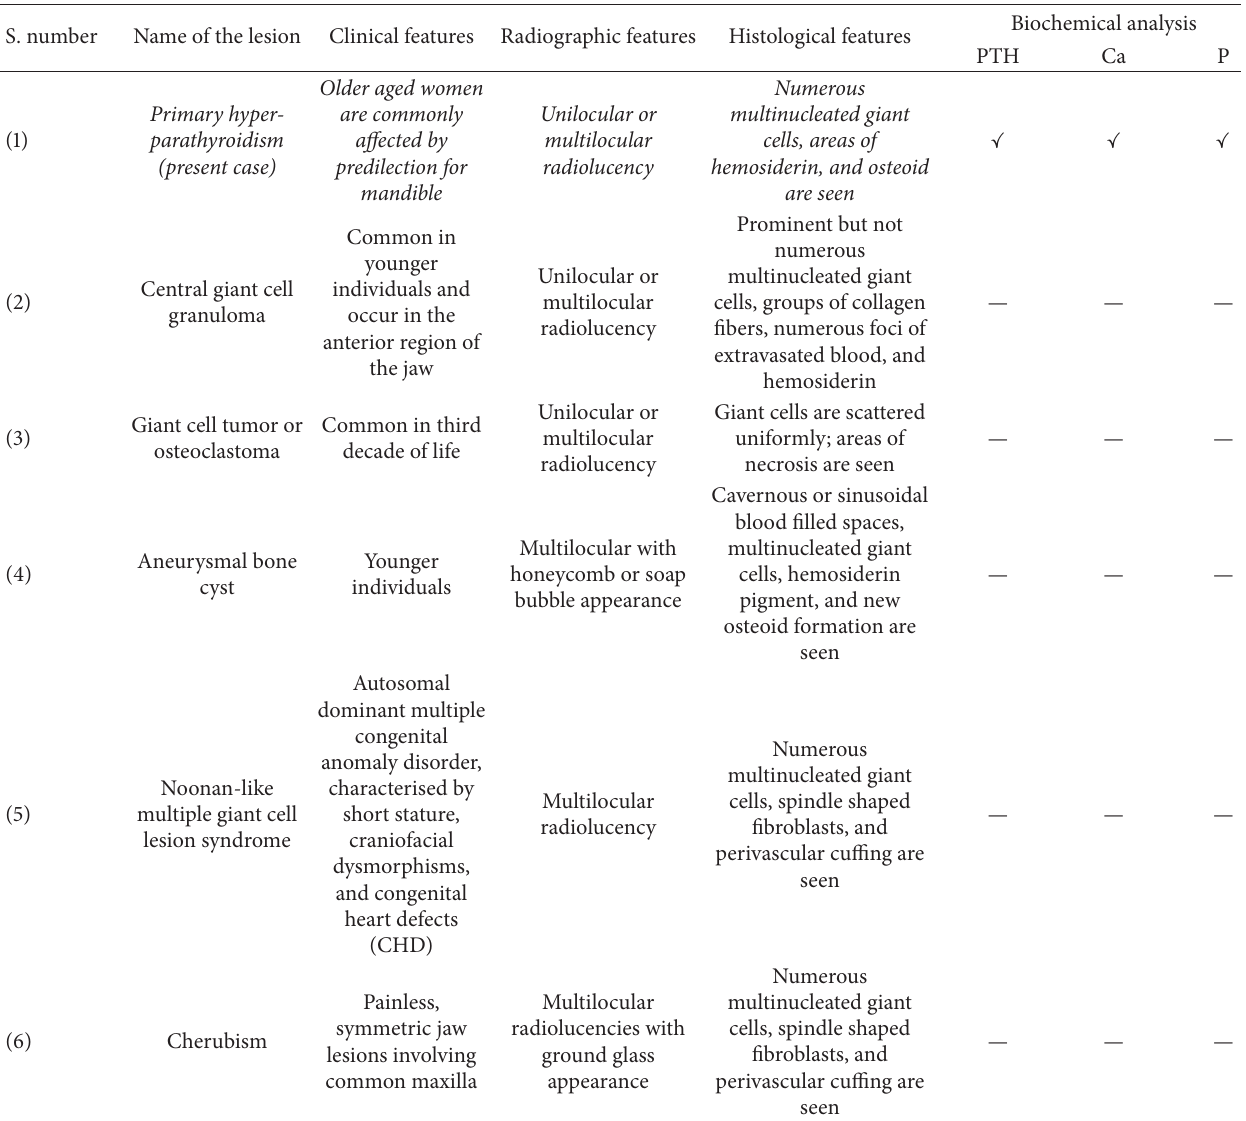
Table 1: Differential diagnosis of giant cell